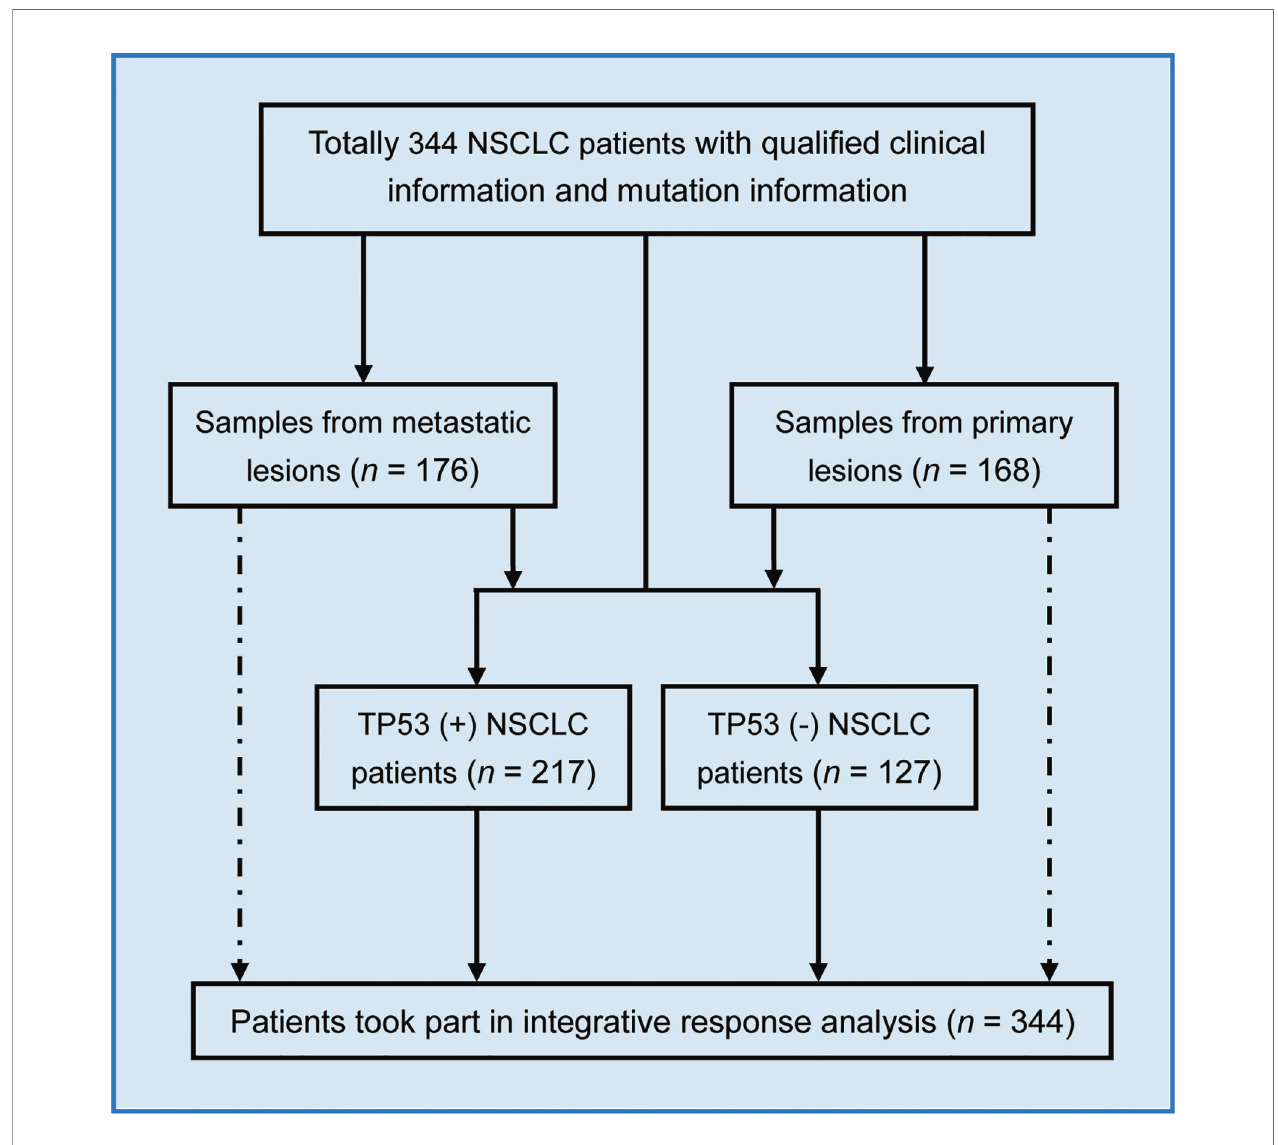
FIGURE 1 | Flow chart showing patient selection and analysis method used in